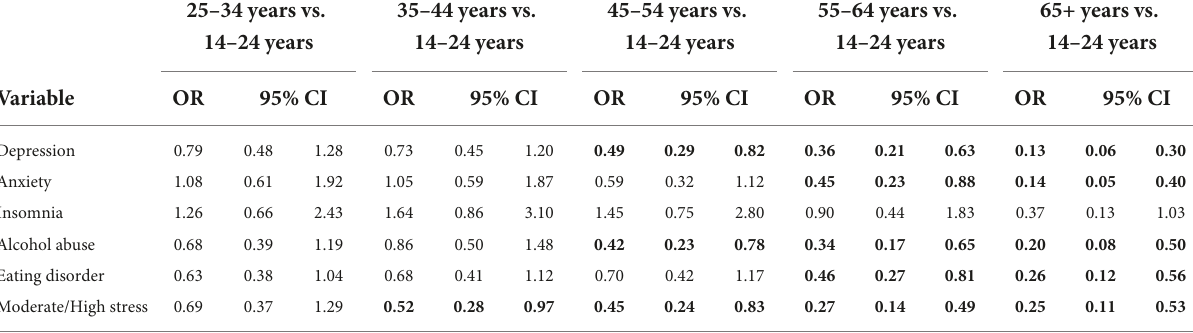
TABLE 2 Adjusted odds ratios (ORs) stratified by age group with the age category “14–24 years” being the reference. 25–34 years vs. 35–44 years vs. 45–54 years vs. 55–64 years